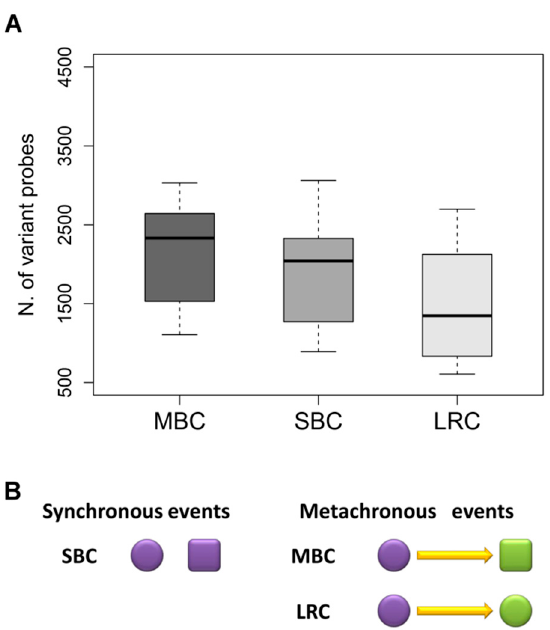
Figure 1. ( A ) Box plots showing the number of probes found to be variantly expressed between tumor pairs from women with metachronous (MBC), synchronous (SBC), and locally relapsed (LCR) breast cancer; ( B ) Schematic representation of sources of variability between pairs from synchronously (SBC) and metachronously (MBC, LRC) diagnosed tumors from the same patient. Shape (square vs. circle) represents genetic background, whereas different color refers to time-related variability. Yellow arrows represent the elapsed time between metachronous events.